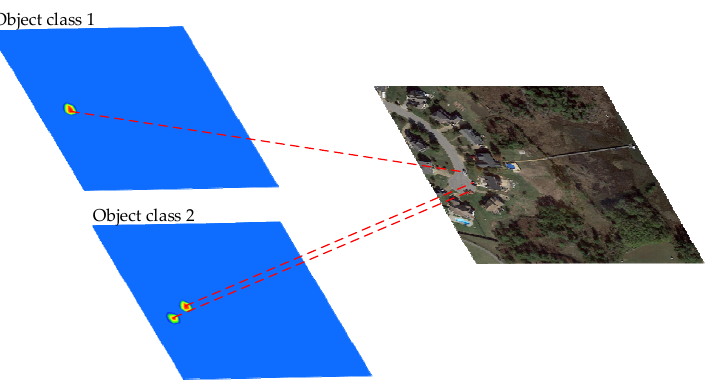
Figure 2. From heatmap to coordinates. The local maximum position is used as the prediction coordinates of the object.